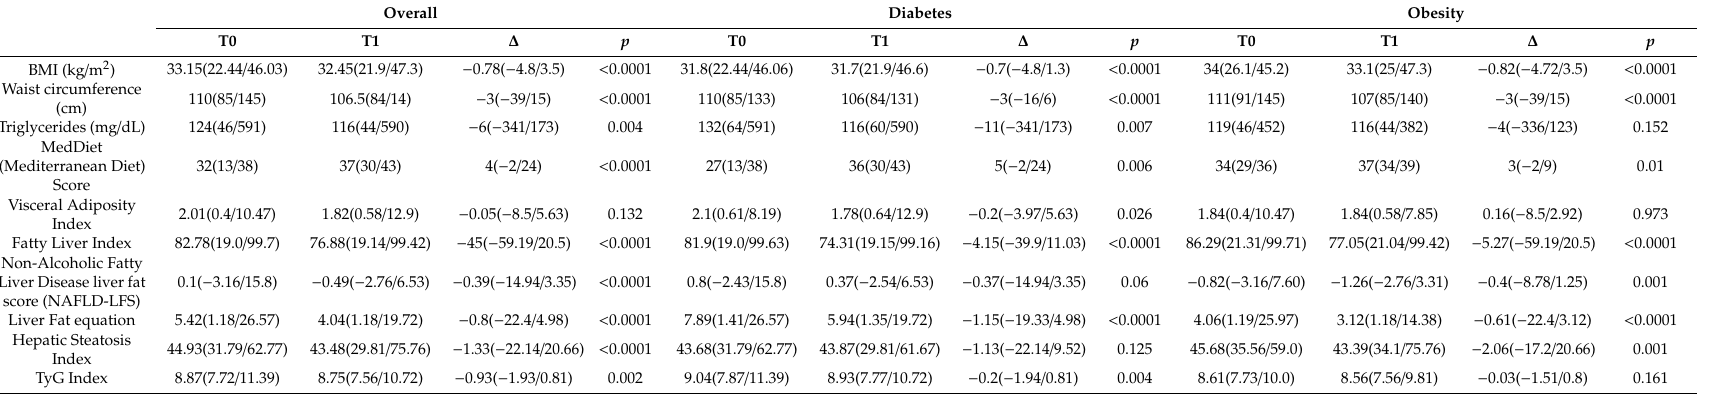
Table 2. Anthropometric, nutritional data and hepatic steatosis indices at baseline (T0) and after three months (T1) of intensive lifestyle program. Data are expressed as median (min / max).